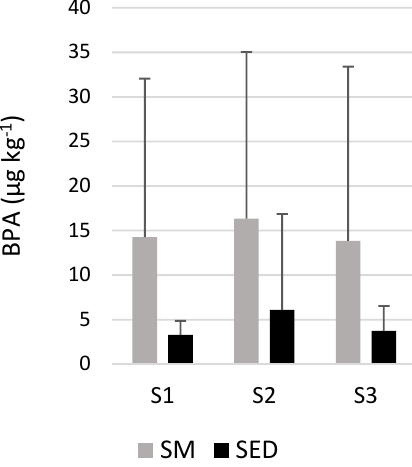
Figure 7. Average BPA concentrations in the suspended matter (SM) and sediment samples (SED) collected at stations S1 to S3 in the Kaštela Bay (Adriatic Sea, Croatia) over two years (April 2015 to March 2017).